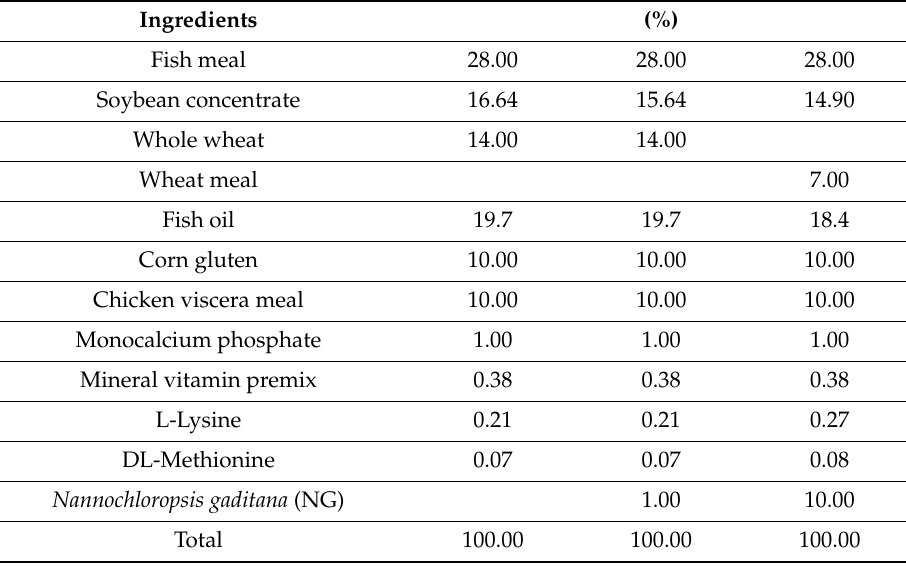
Table 1. Formulation, proximate, sodium and calcium composition of experimental diets.